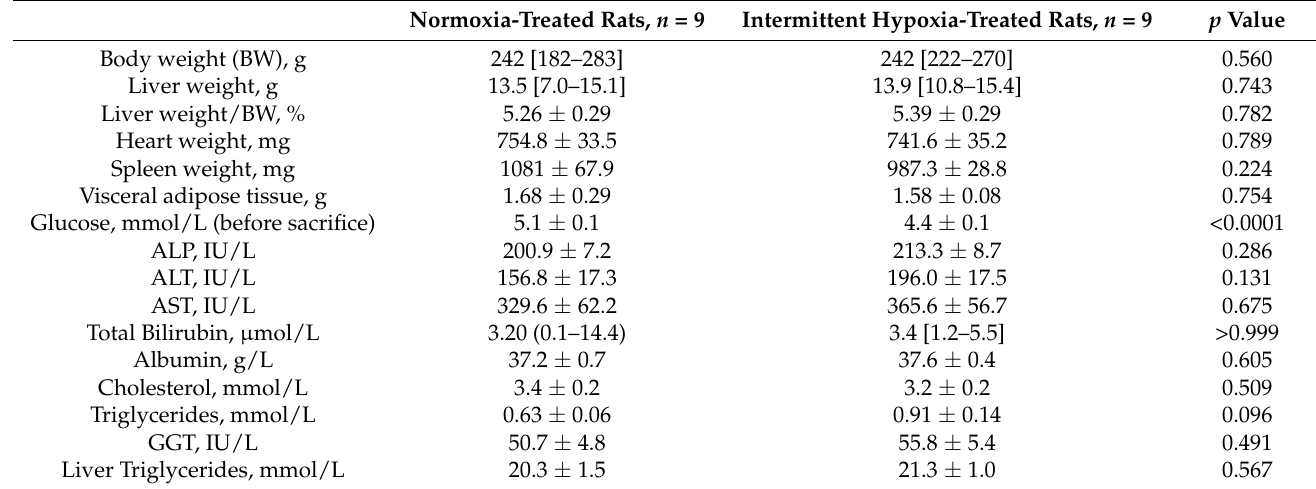
Table 1. Clinical and biological